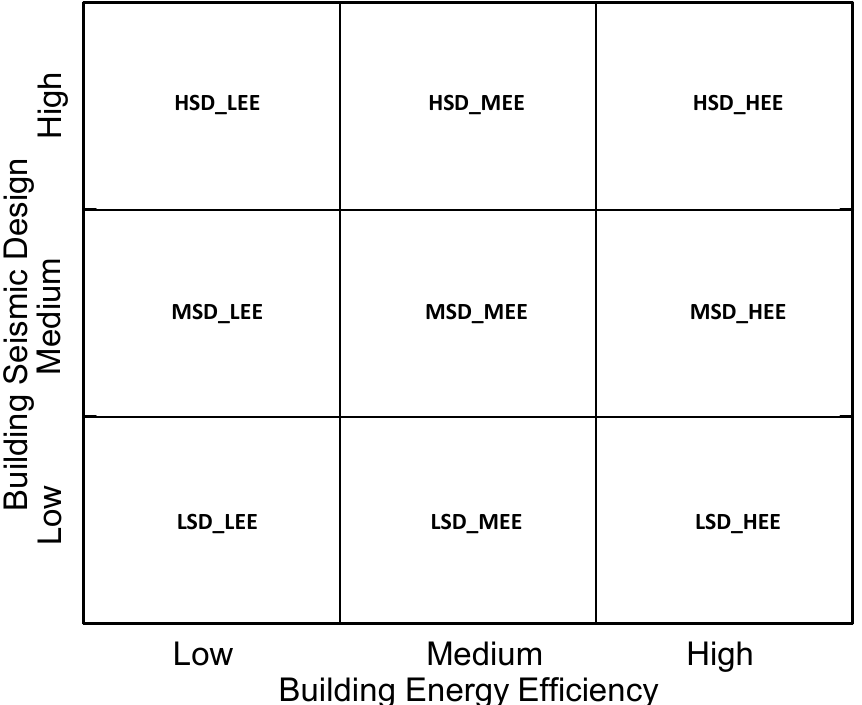
Figure 9. Building typologies matrix.